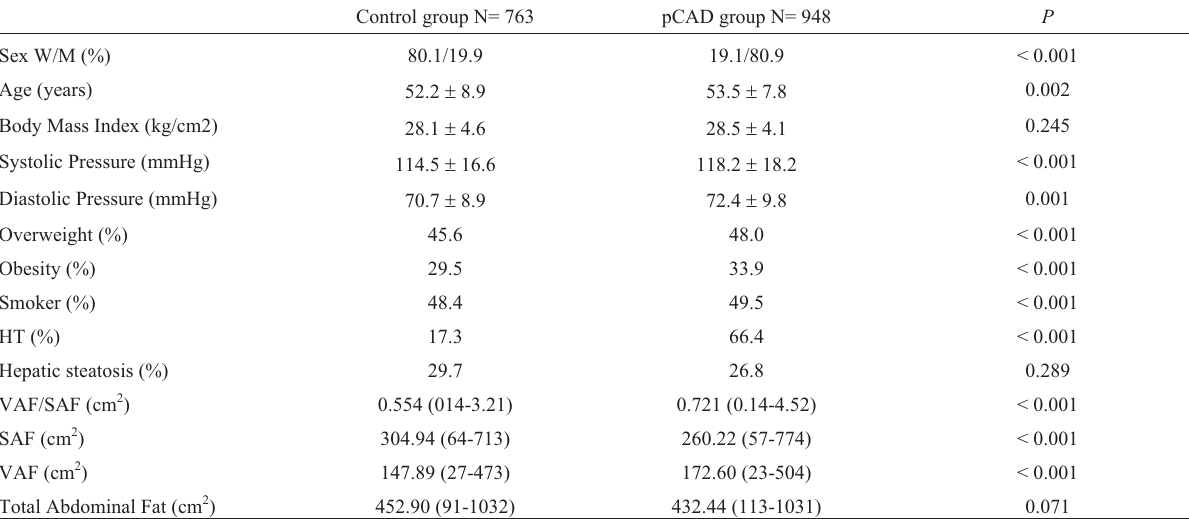
Table 1 - Demographic and clinical characteristics of the study population Control group N= 763 pCAD group N=